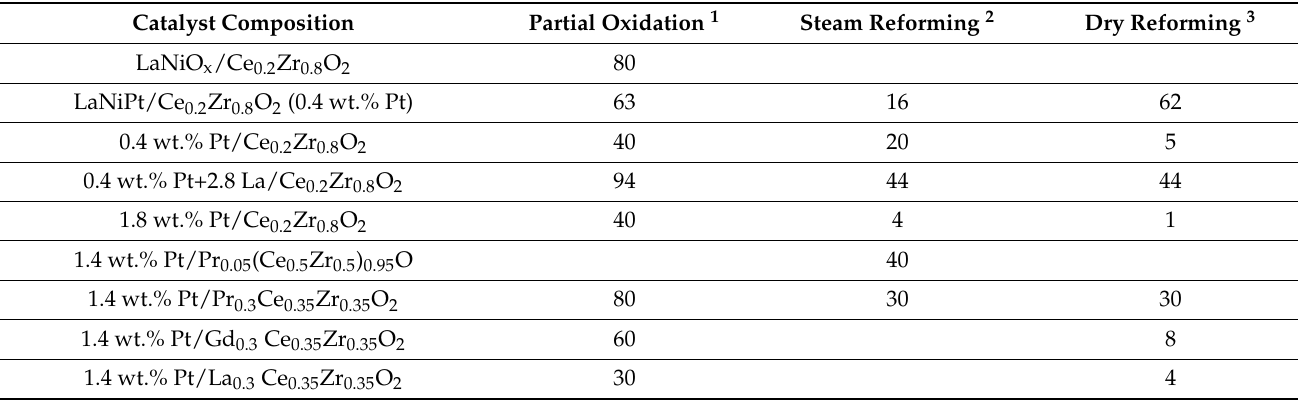
Table 3. Effective first-order rate constants (s − 1 ) of CH 4 reforming at 700 ◦ C on separate corundum channels with supported active components [111,112].